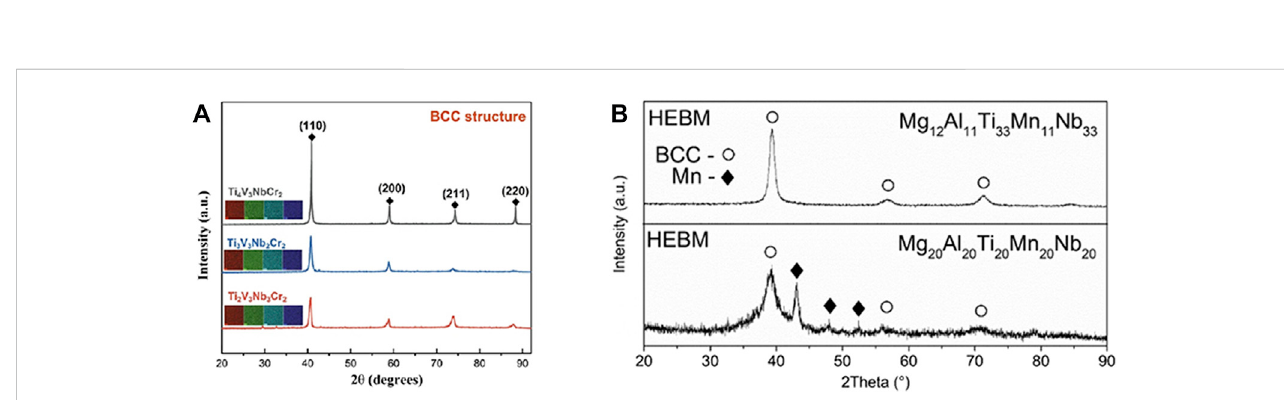
FIGURE 4 XRD patterns of the TiVNbCr system alloy synthesized by the VAM method (A) (Cheng et al., 2022); and XRD patterns of Mg 12 Al 11 Ti 33 Mn 11 Nb 33 HEA synthesized by the HEBM method (B) (Strozi et al., 2021a).